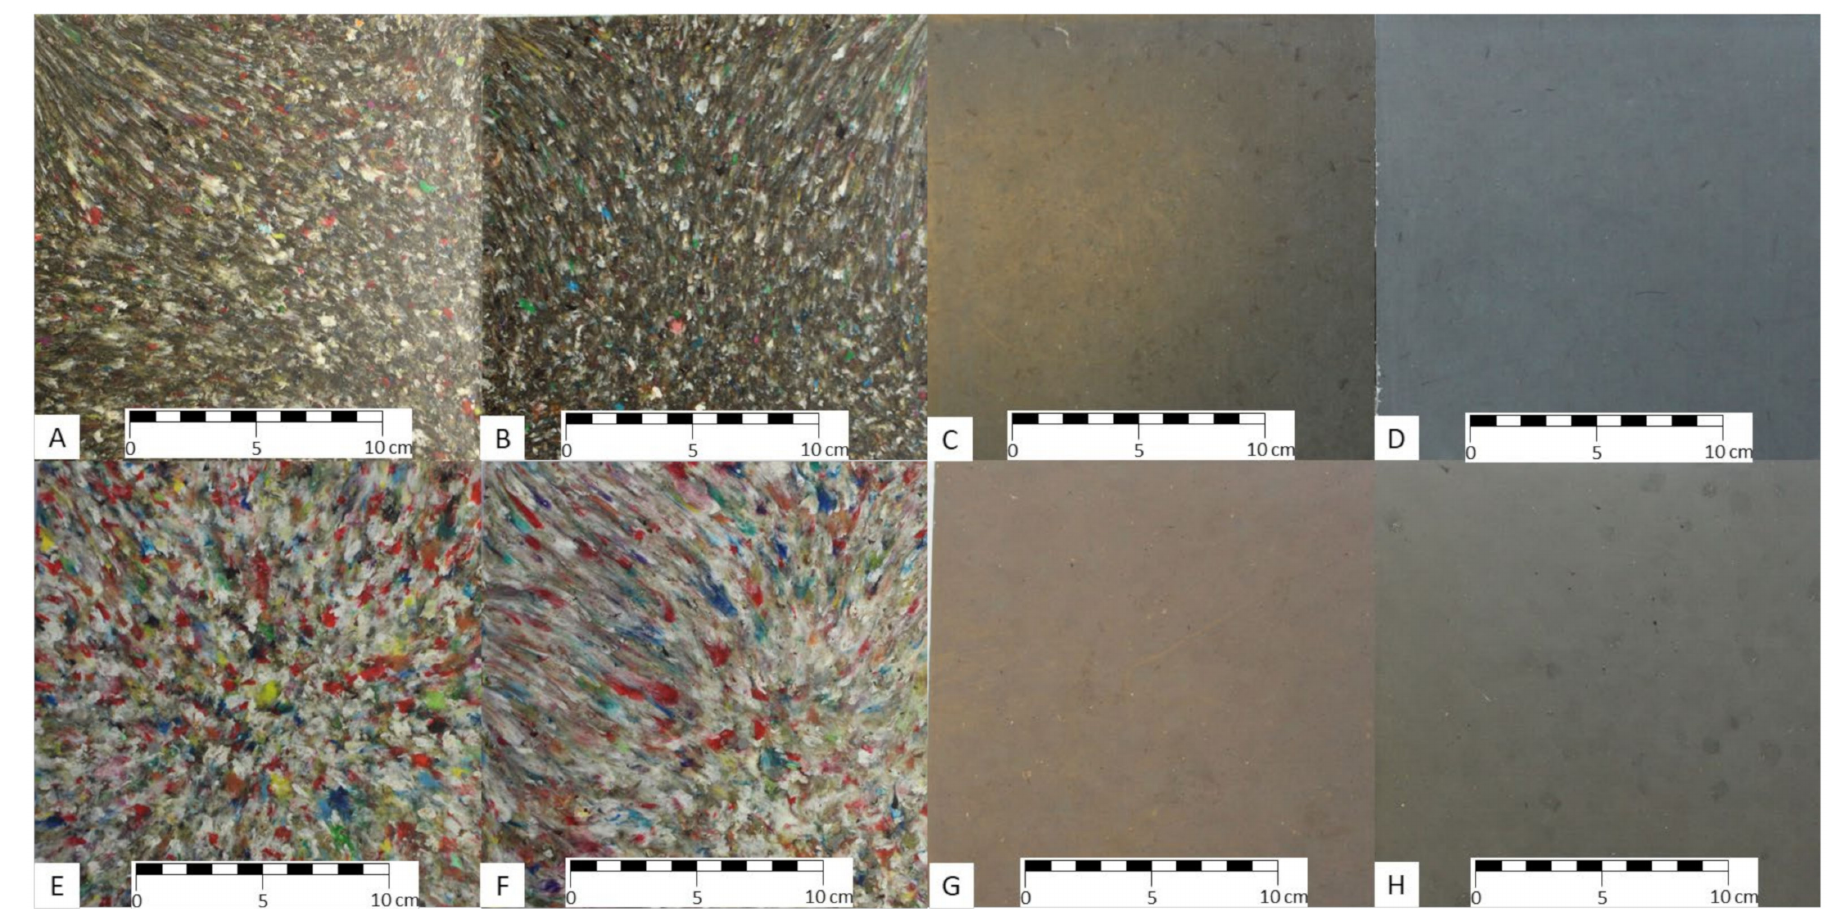
Figure A7. Exemplary photos of vacuum compression moulded plates: P_PE— A ; P_W,PE— B ; P_C,PE— C ; P_W,C,PE— D ; P_PP— E ; P_W,PP— F ; P_C,PP— G ; and P_W,C,PP— H